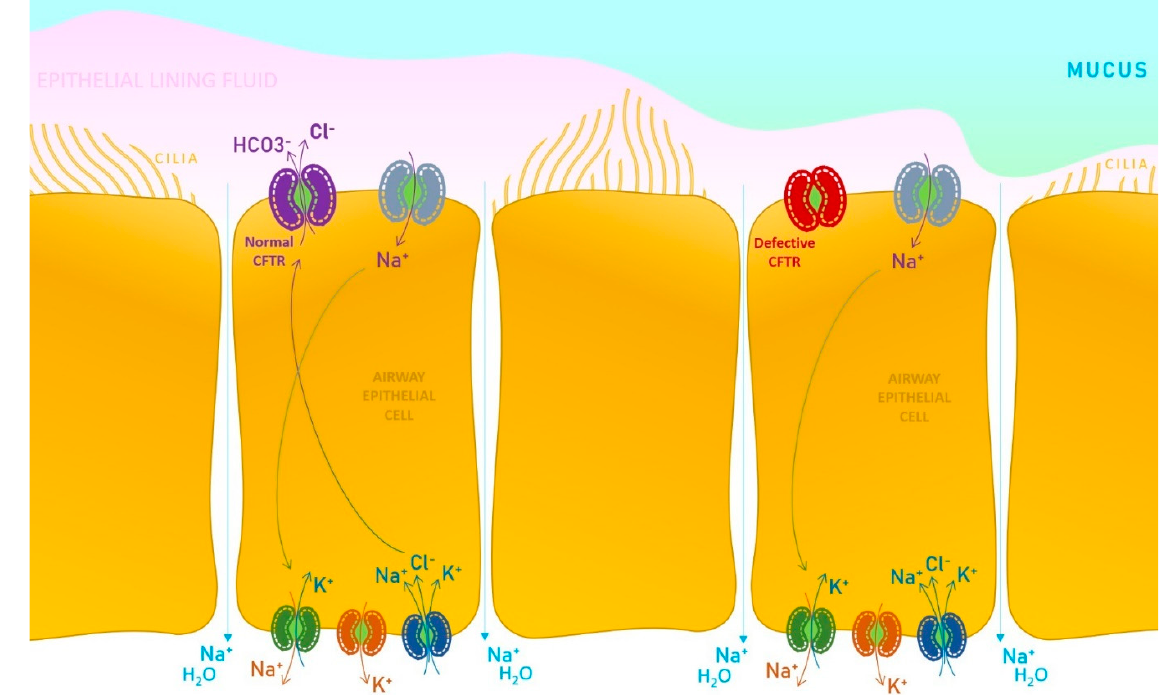
Figure 1. The pathogenic mechanism in cystic fibrosis, at the level of an airway epithelial cell. Briefly, a mutation in the CFTR gene prevents Cl ⁻ being excreted from the cell, leading to defective mucous clearance, pathogens clustering and inflammatory events. [6–9].